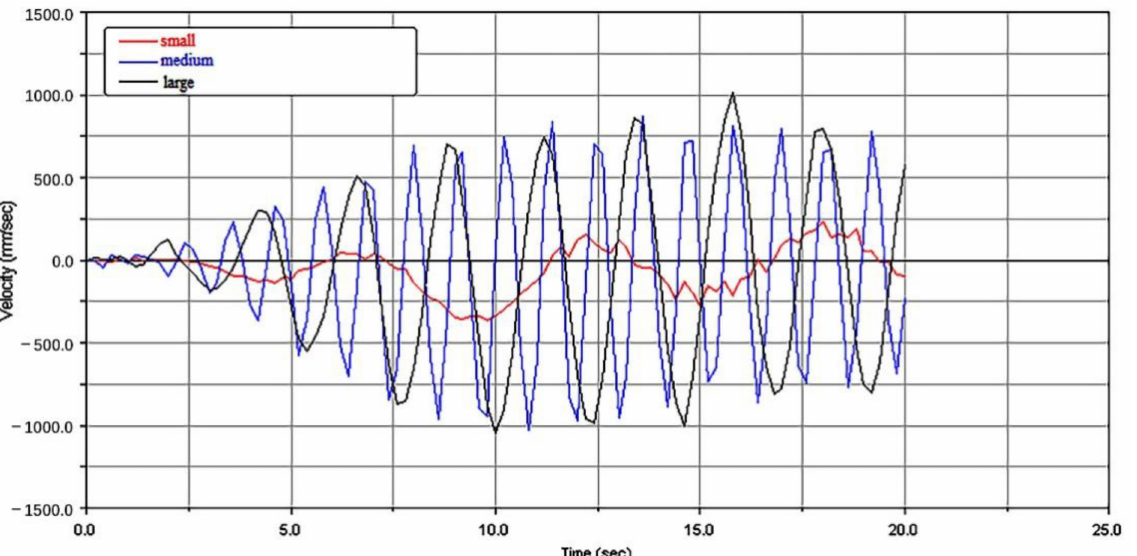
Figure 15. Displacement distribution with different end loads.